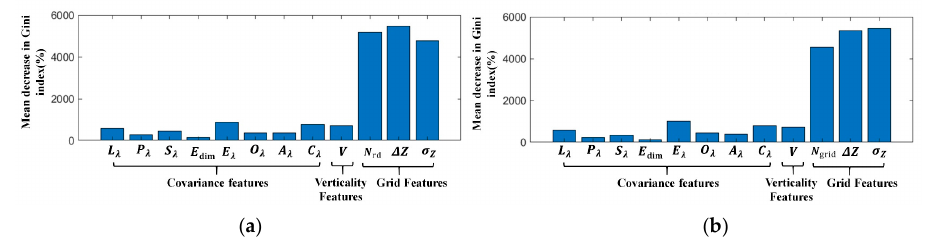
Figure 16. Feature importance is obtained from the classification results of different feature combi- nations. ( a ) Relative projection density and commonly used features, ( b ) Traditional projection density and commonly used features.